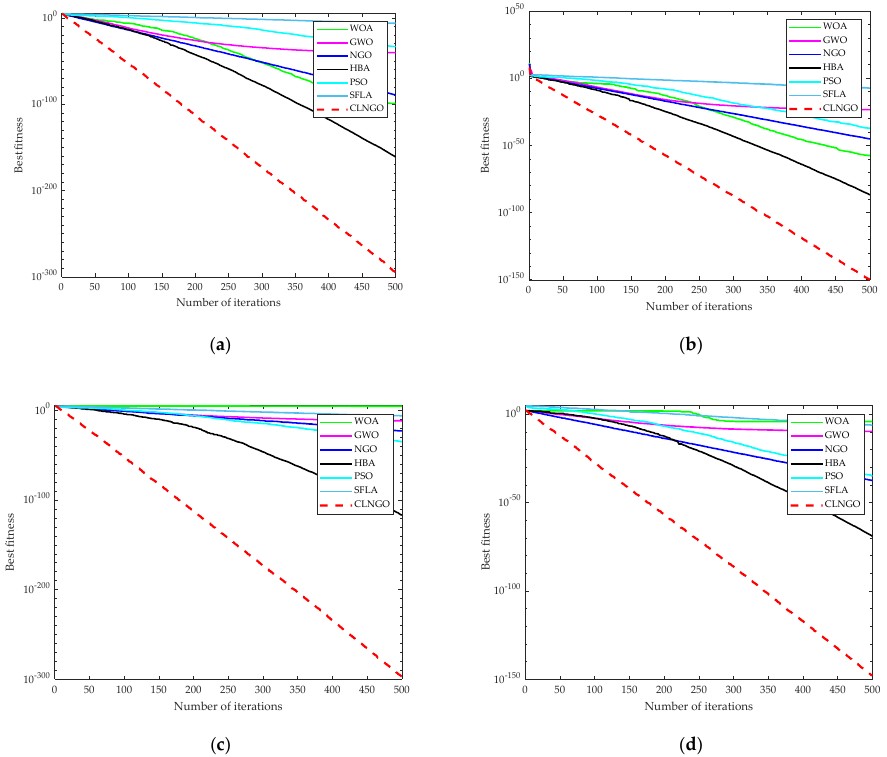
Figure 2. Convergence curve of the high-dimensional single objective function. ( a ) The convergence curve of function f1. ( b ) The convergence curve of function f2. ( c ) The convergence curve of function f3. ( d ) The convergence curve of function f4